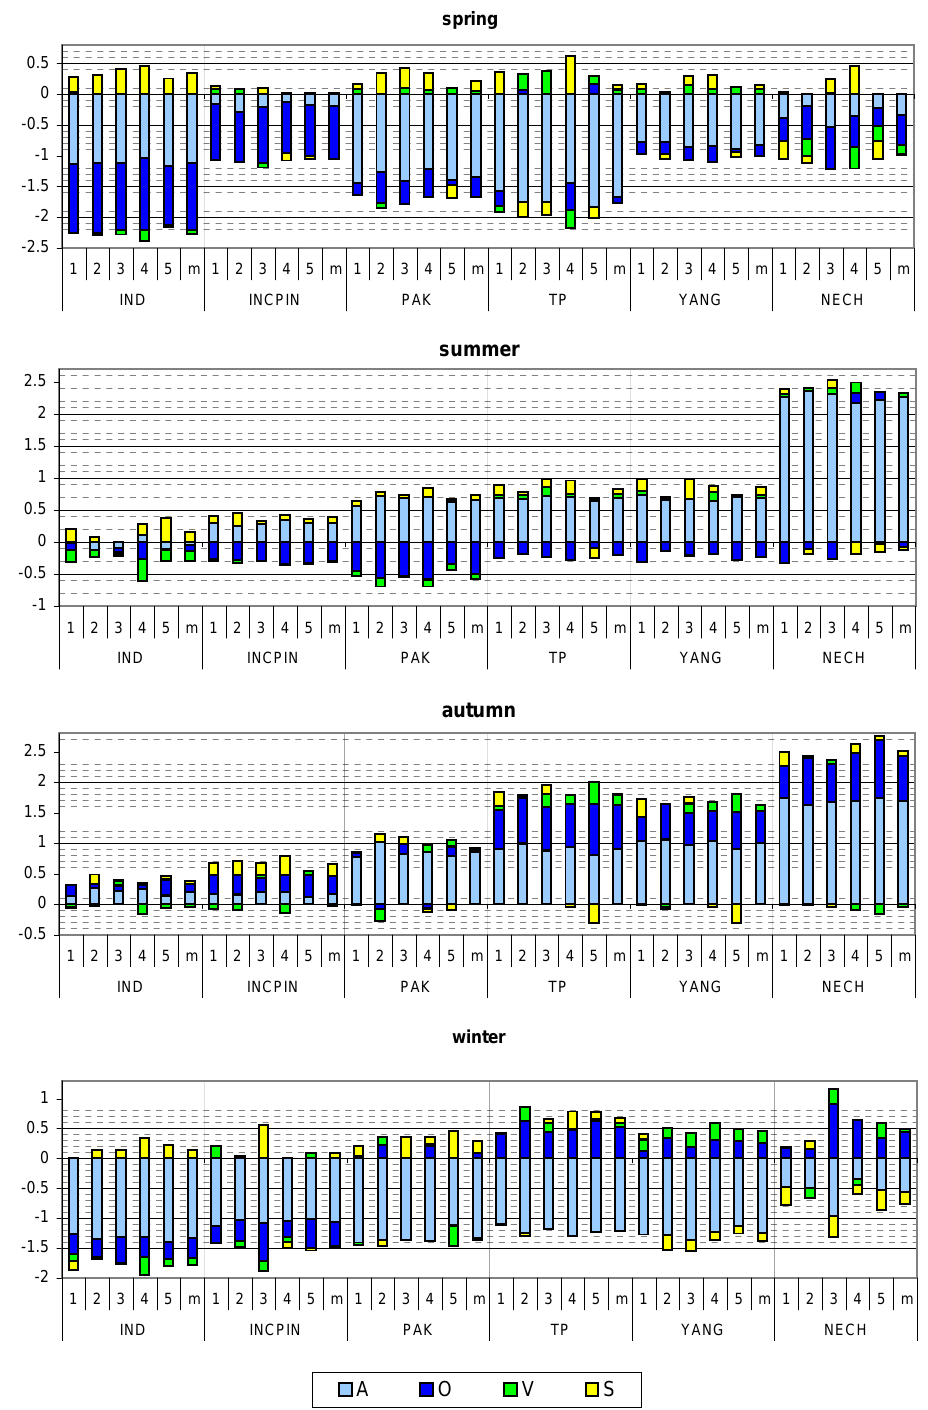
Fig. A1. Factors contributing to the seasonal temperature change [K] between mid-Holocene (6k) and present-day (0k) climate for six regions in the area of the Asian monsoon. Depicted are seasonal averages for all 120-year periods as well as the 600-year mean. Light blue colours show the results of the atmosphere-only run, i.e. the direct response of atmospheric dynamics (A) to changes in insolation. Dark blue colours represent the contribution of ocean-atmosphere-interaction (O), including sea-ice dynamics. Green colours indicate the contribution of vegetation-atmosphere interaction (V). Yellow colours reveal the contribution of the synergy (S) between atmosphere – ocean and atmosphere – vegetation interactions. Please note the change in